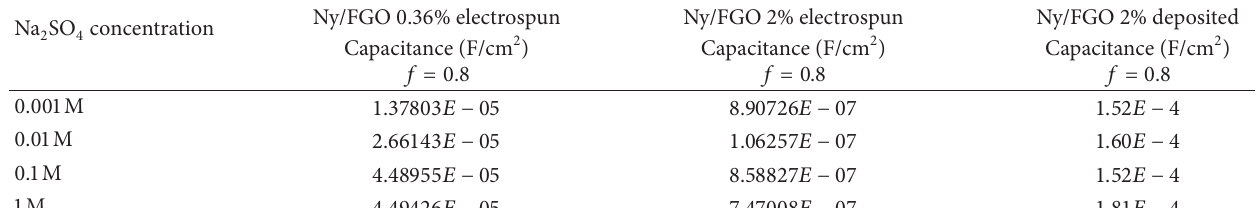
SO concentrations. 2 4